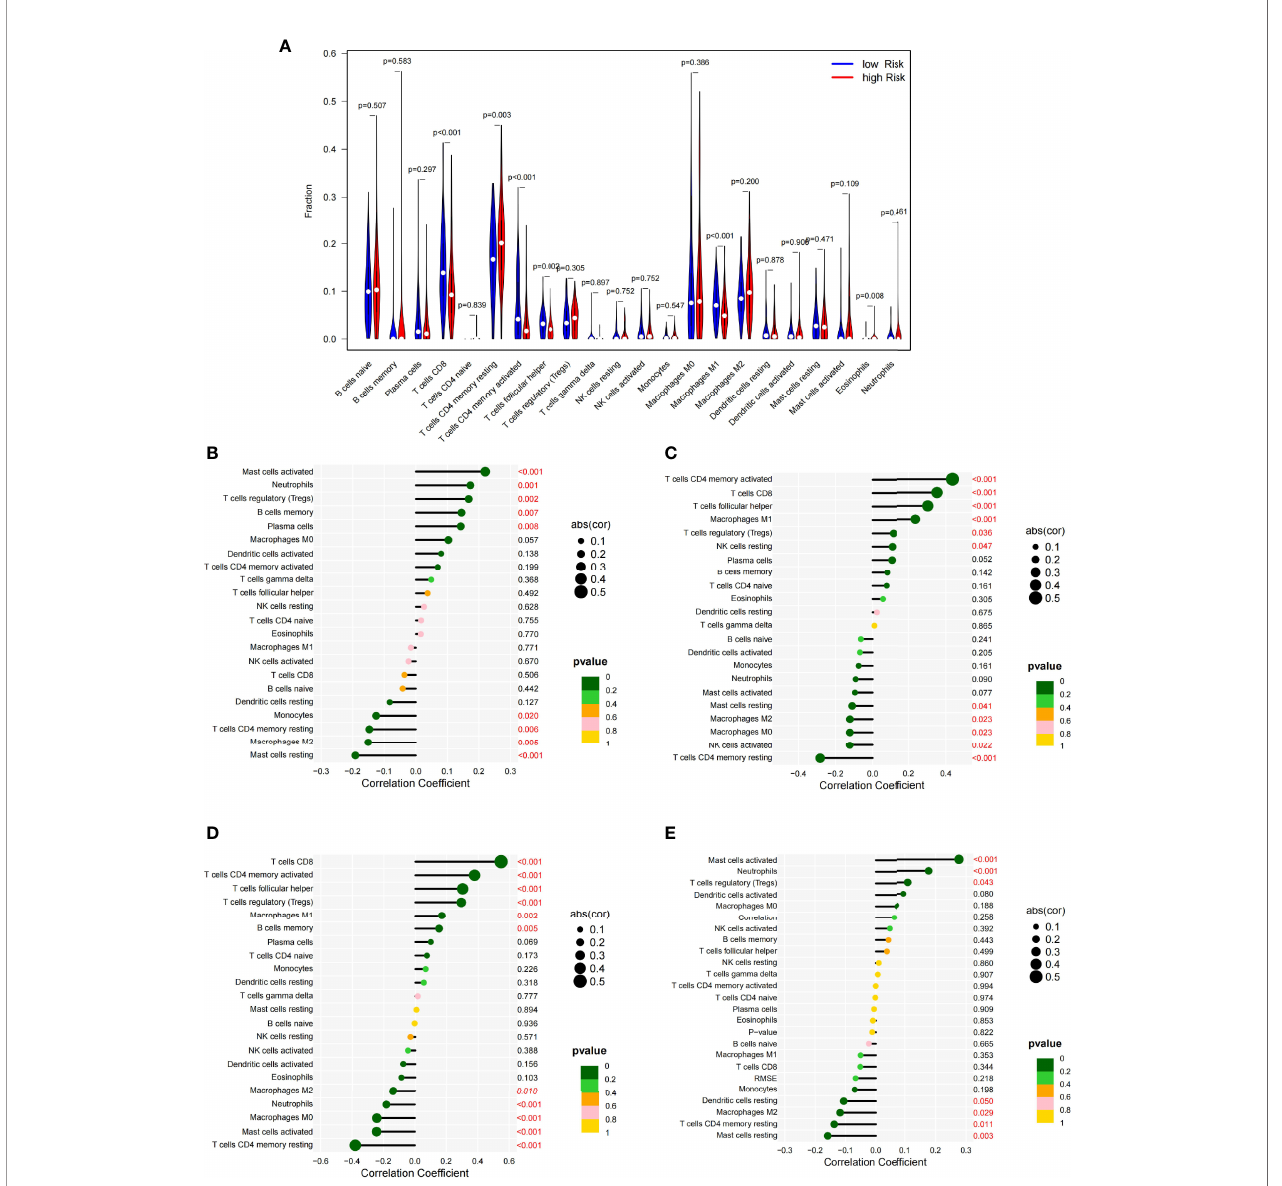
FIGURE 6 | Vioplot of the absolute abundance of 22 immune in fi ltration cells between the high- and low-risk groups (A) . Correlation coef fi cients between the immune cells and CD28 (B) , CTLA4 (C) , PDCD1 (D) , and TNF (E)